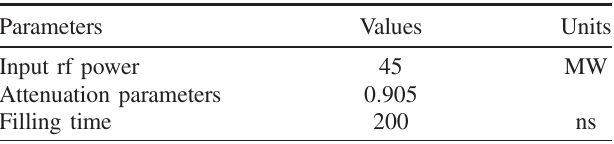
TABLE II. Parameters of the resonant ring.